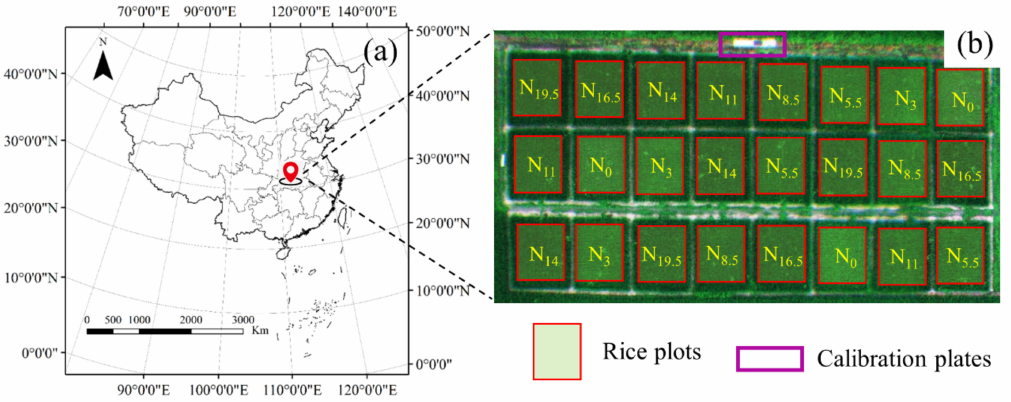
Figure 1. Study area and rice-plot settings: ( a ) experimental-area location; ( b ) nitrogen-gradient layout of rice